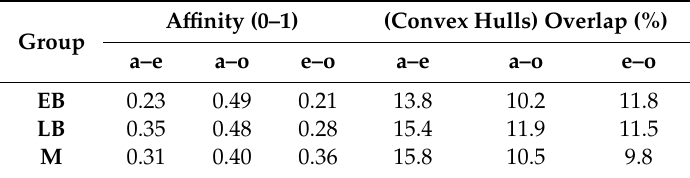
Table 2. A ffi nity scores and proportion overlap (convex hulls) for / a e o / in the reading task. Results displayed by group (Early Bilinguals (EB), Late Bilinguals (LB) and Monolinguals (M)). A ffi nity (0–1) Group